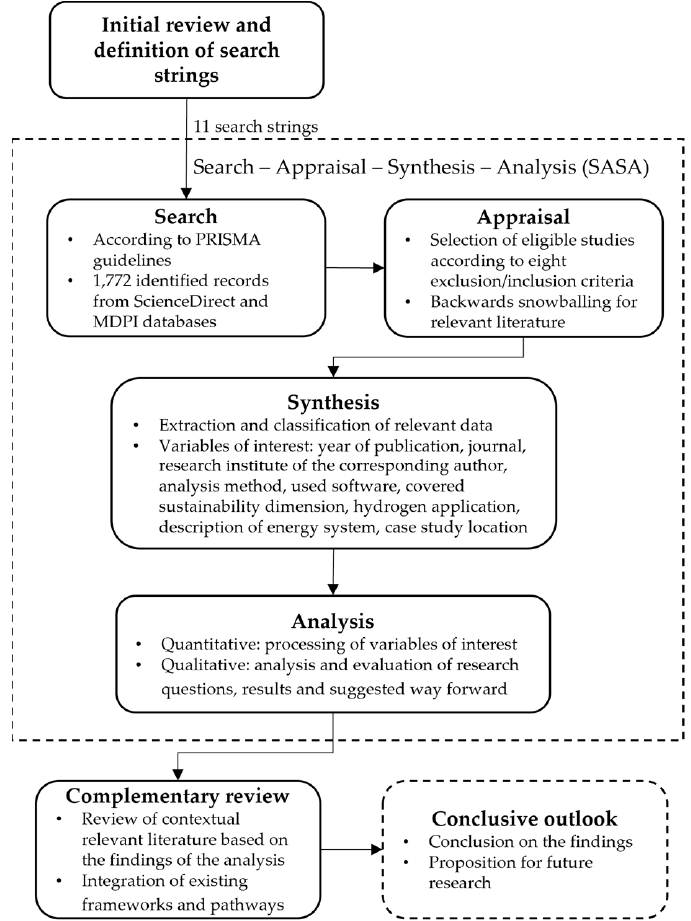
Figure 1. Workflow applied in the present paper, including Search–Appraisal–Synthesis–Analysis approach.